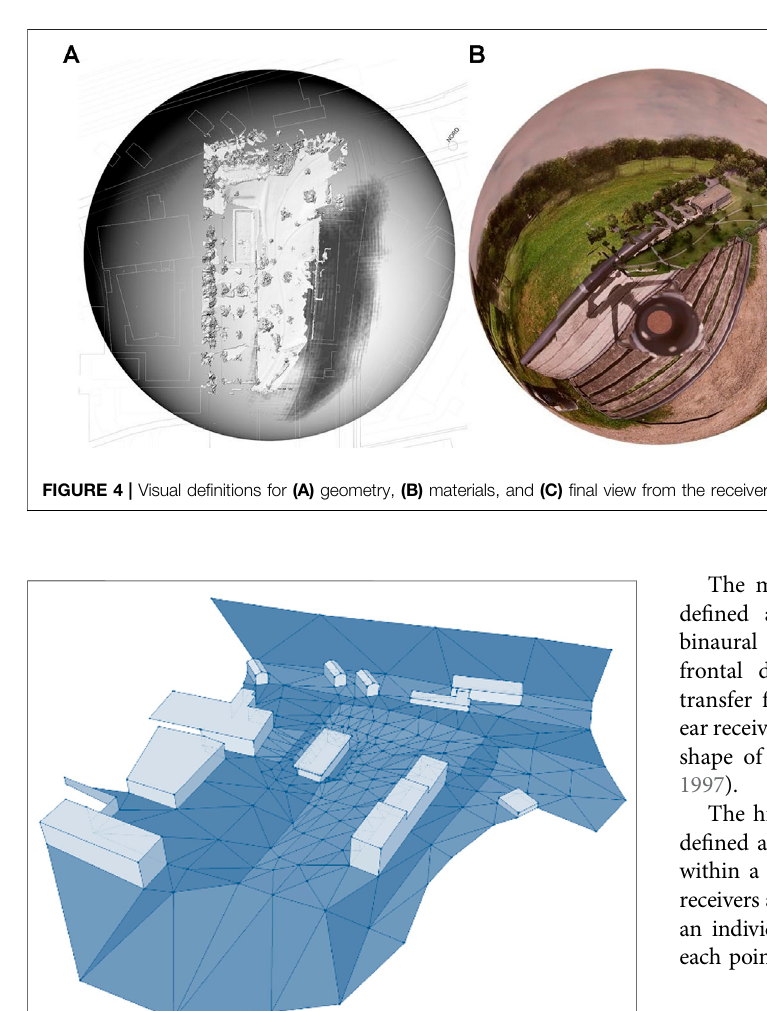
Frontiers in Built Environment |